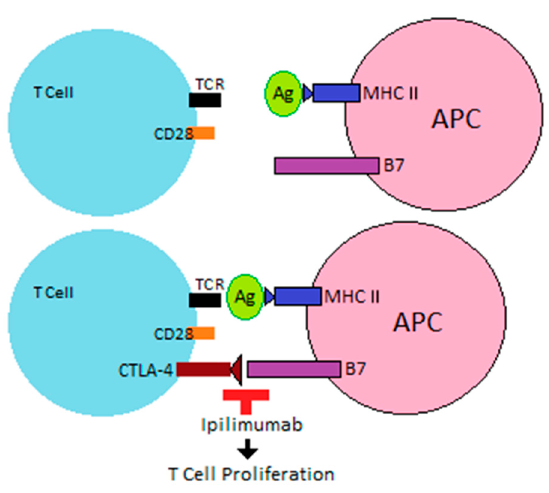
Figure 1. Ipilimumab prevents negative T cell co-receptor CTLA-4 interaction with B7 on APCs, allowing for T cell proliferation.